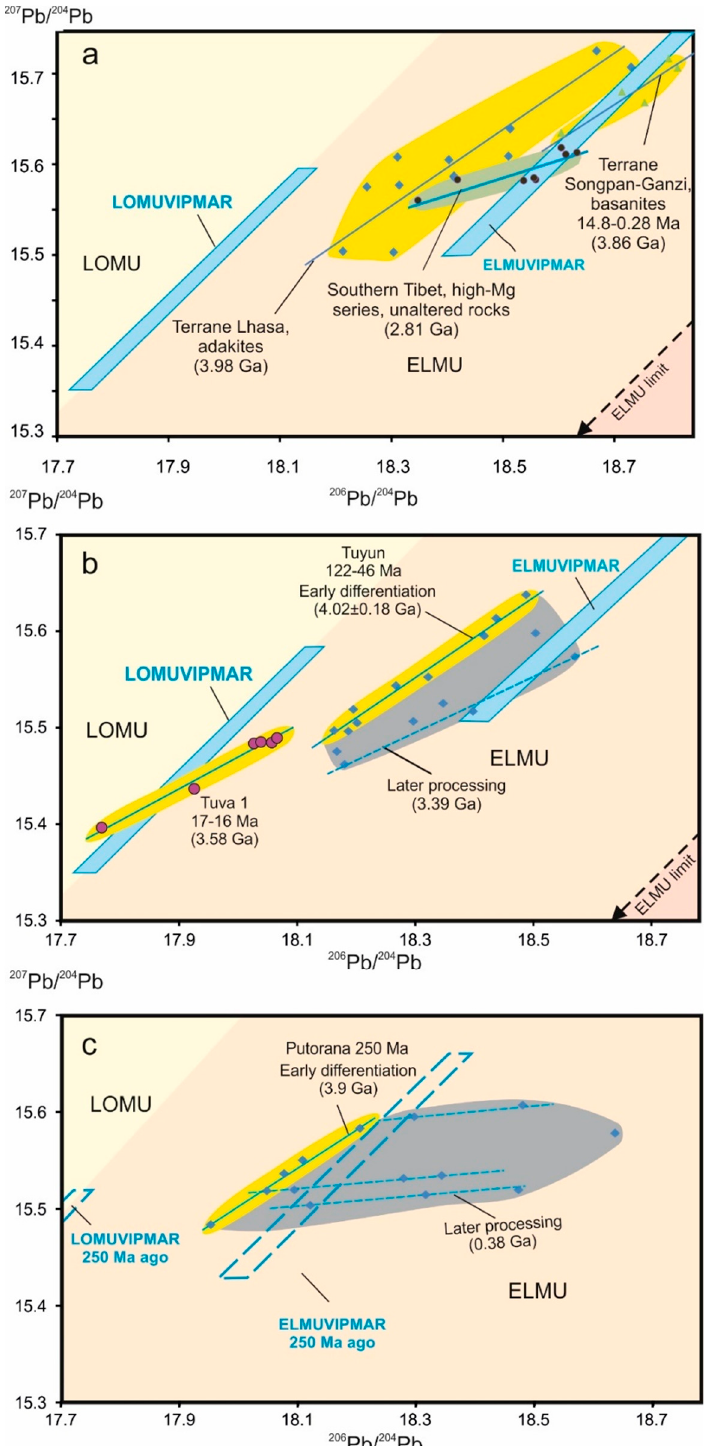
Figure 7. Diagrams of 207 Pb / 204 Pb versus 206 Pb / 204 Pb for volcanic rocks from the volcanic fields of Tibetan Plateau ( a ), Tuyun basin (Chinese Tien Shan) and Tuva (Eastern Sayans) ( b ), and Putorana Plateau (north of the Siberian paleocontinent) ( c ). In diagrams ( a , b ), the LOMUVIPMAR and ELMUVIPMAR compositions, as well as LOMU–ELMU and ELMU limit discriminate lines are shown as in Figure 5. In diagram ( c ), data points of traps and the LOMUVIPMAR and ELMUVIPMAR compositions were recalculated to the age of 250 Ma. In diagram ( b ), calculation of the secondary errorchron 4.02 Ga was performed using the Isoplot program [87]. Data are from [53,90–95]. Late Archean (2.9–2.6 Ga).